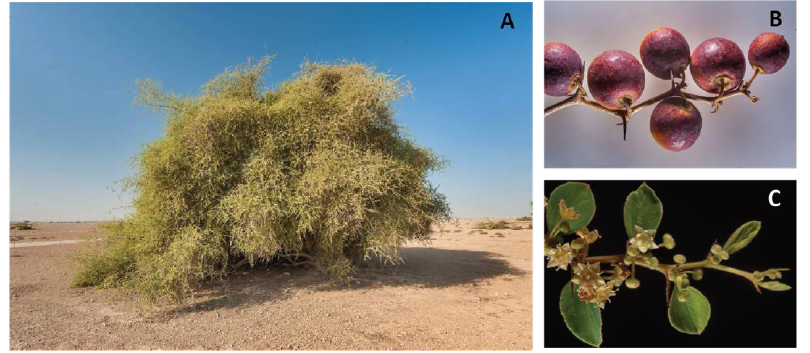
Figure 1. ( A ) Ziziphus nummularia plant, ( B ) Ziziphus nummularia fruit, and ( C ) Ziziphus nummularia leaves. Images were obtained from https://www.floraofqatar.com/ziziphus_nummularia.htm (ac- cessed on 20 June